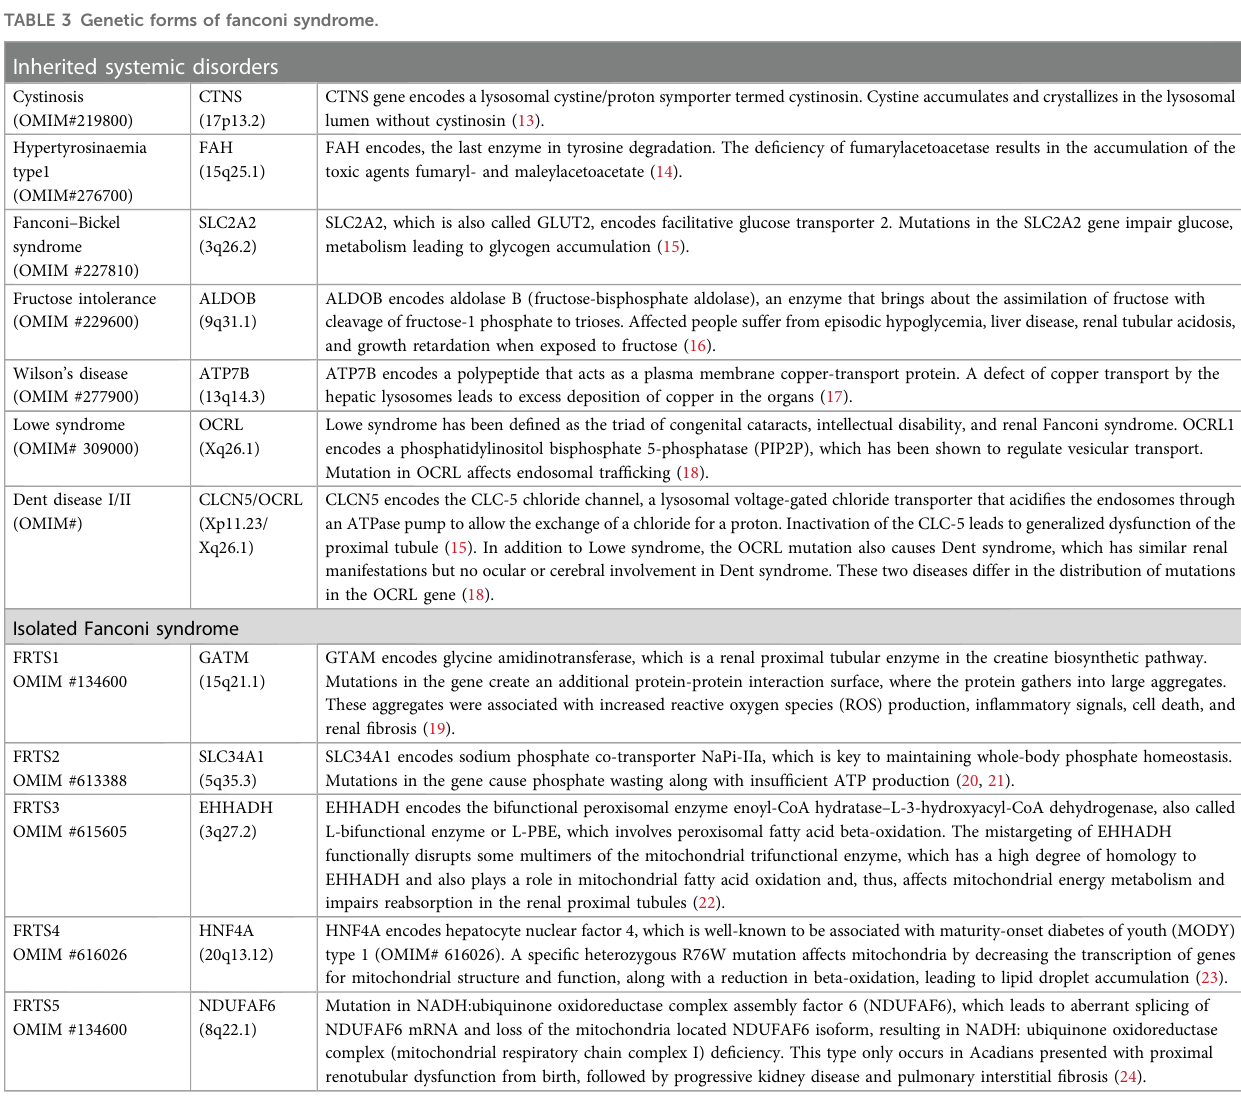
TABLE 3 Genetic forms of fanconi